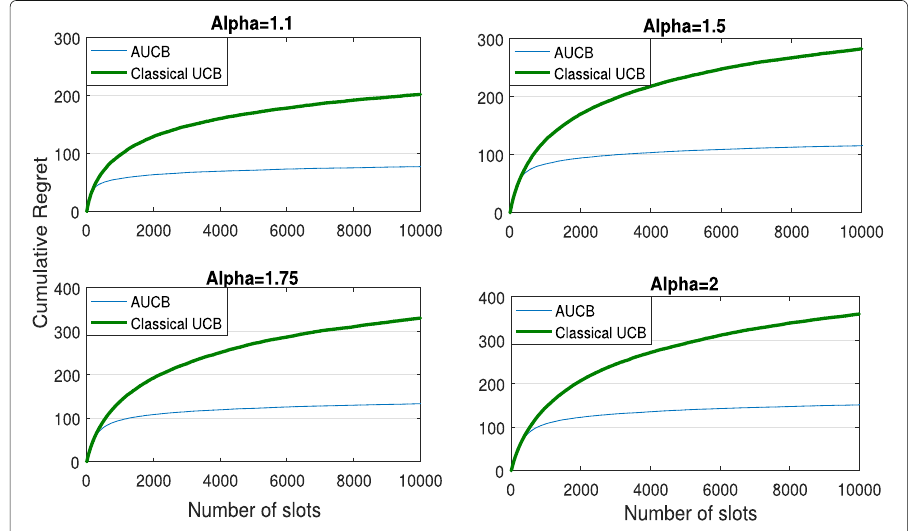
Fig. 4 Regret of the two approaches with different values of